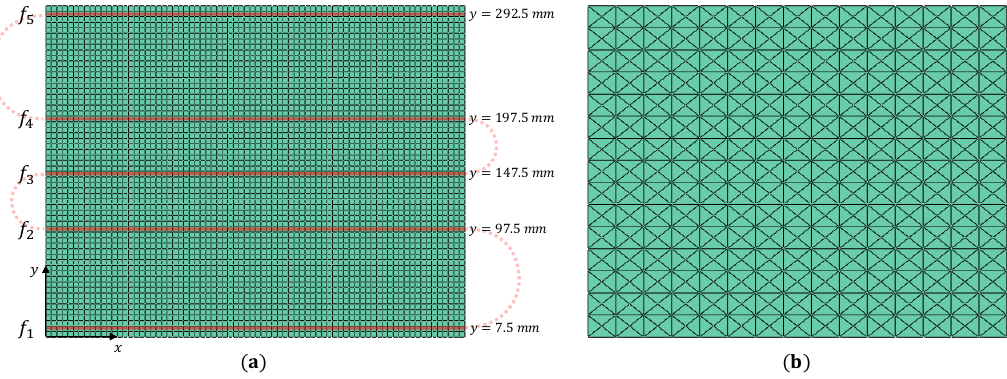
Figure 3. The discretization scheme for the plate: ( a ) FE/iFEM mesh with the fiber optic sensor paths shown, and ( b ) the 15 × 15 smoothing mesh using 900 SEA3 [51]